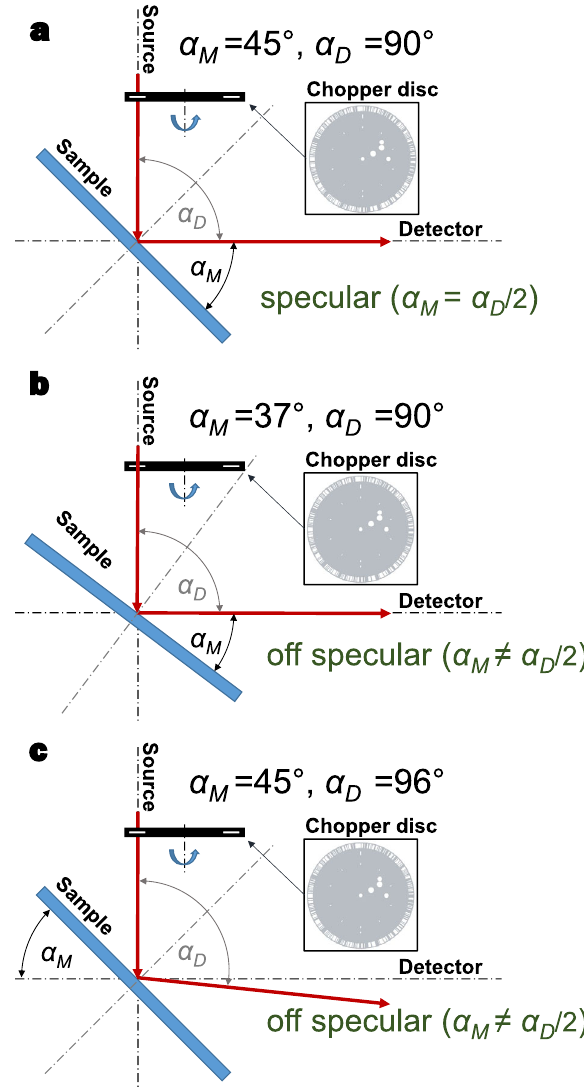
Fig. 5 | MAGIE experimental setup. Schematic of the experimental arrangement used in MAGIE in terms of the source-to-detector angle ( α D ) and the manipulator angle ( α M ). a Arrangement used for specular TOF measurements, where the incoming beamangleequalsthat of the outgoing beamwithrespectto the surface normal.Off-specularTOFmeasurementscanbemadeeitherbyrotatingthesample relativetotheincomingbeamthroughchanging α M ( b ),orbyrotatingthedetector relative to the incoming beam by varying α D ( c